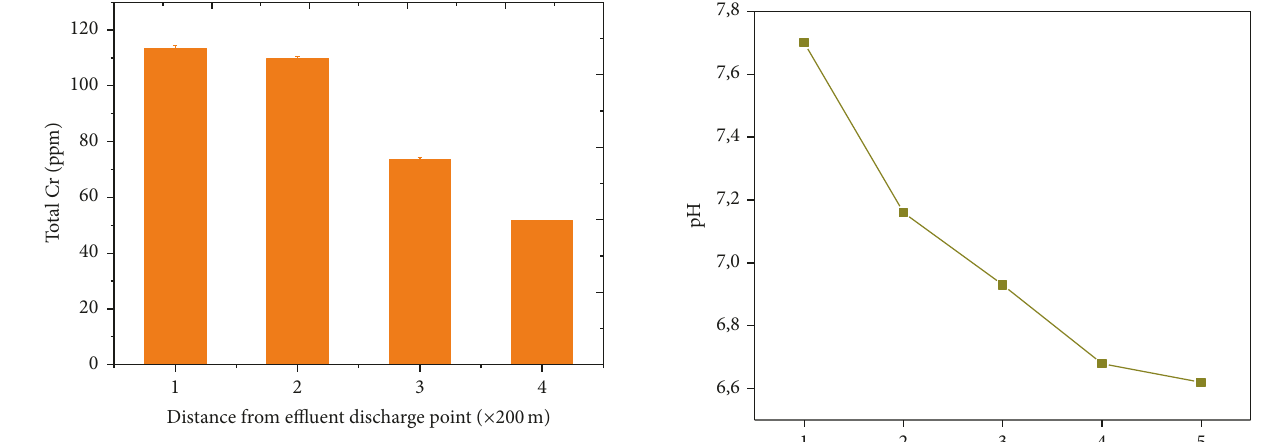
Figure 1: The levels of total Cr(III) corrected for blank (new material) detected in exposed samples against distance from the tannery.